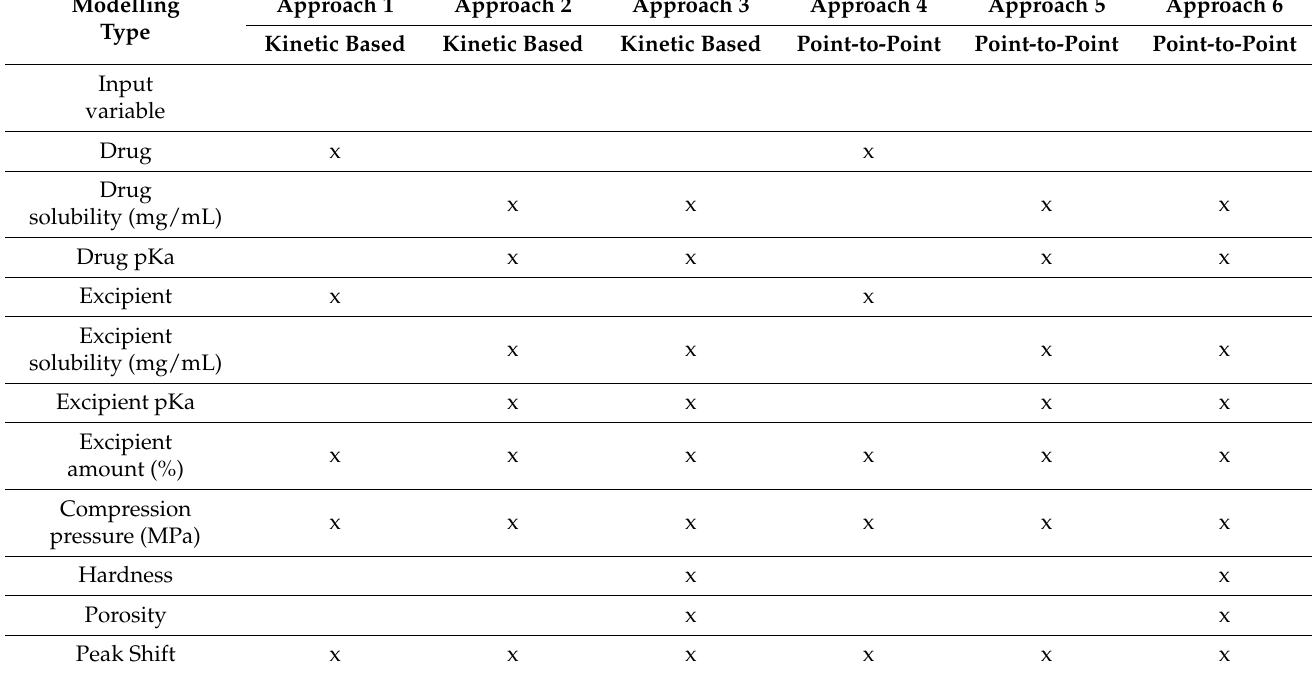
Table 3. Input variables of the various ANN training